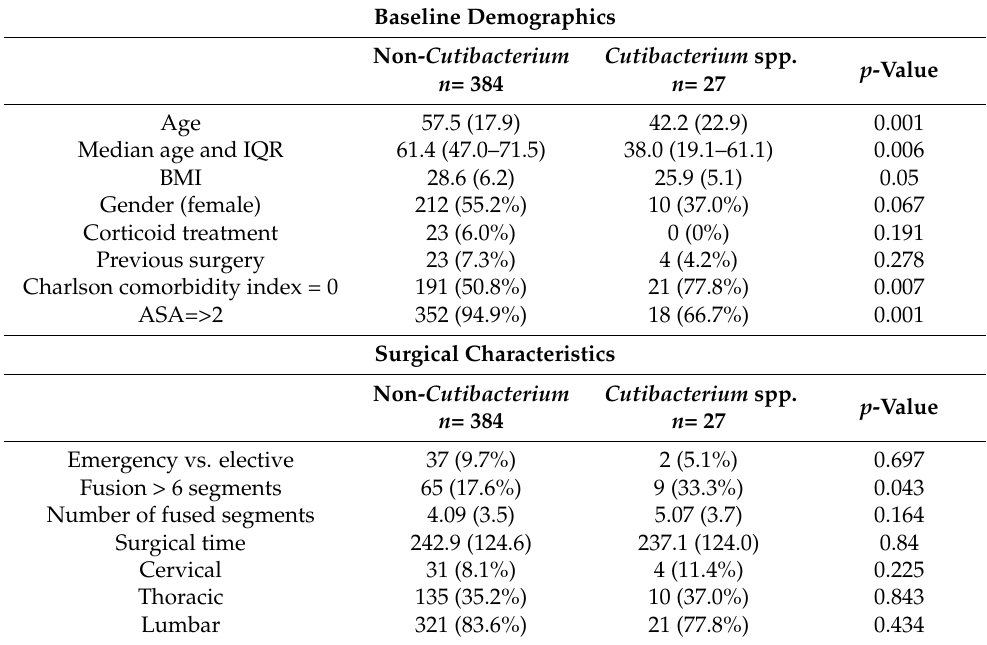
Table 2. Baseline demographics and surgical characteristics of the population.